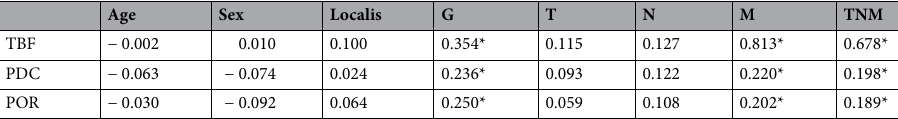
Table 4. Spearman’s rank correlation coefficients between selected tumor budding parameters and clinicopathological parameters. Marked correlation coefficients are significant with p <